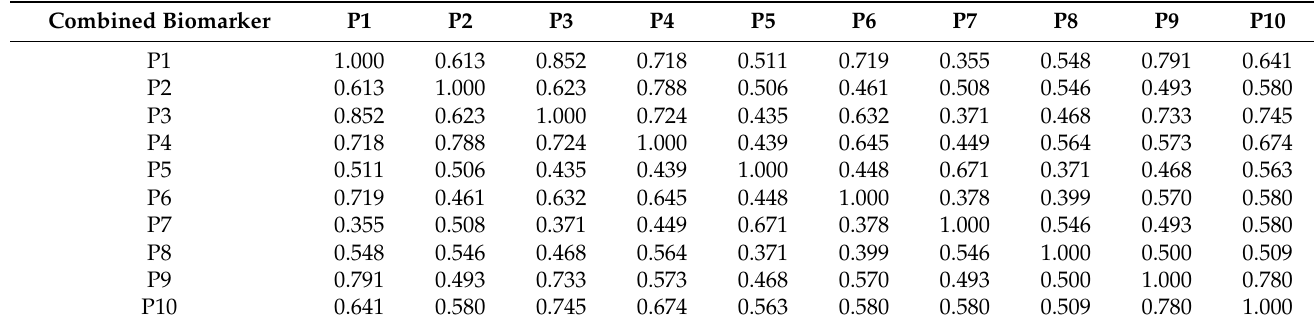
Table 7. Kappa values for the ten participating pathologists in the exploratory analysis of the combined biomarker based on PD-L1 status (<1% vs. ≥ 1%) and TILs (<5% vs. ≥ 5%). Only those TNBC metastases with PD-L1/SP142 scores of ≥ 1% and ≥ 5% TILs were considered positive, and agreement was